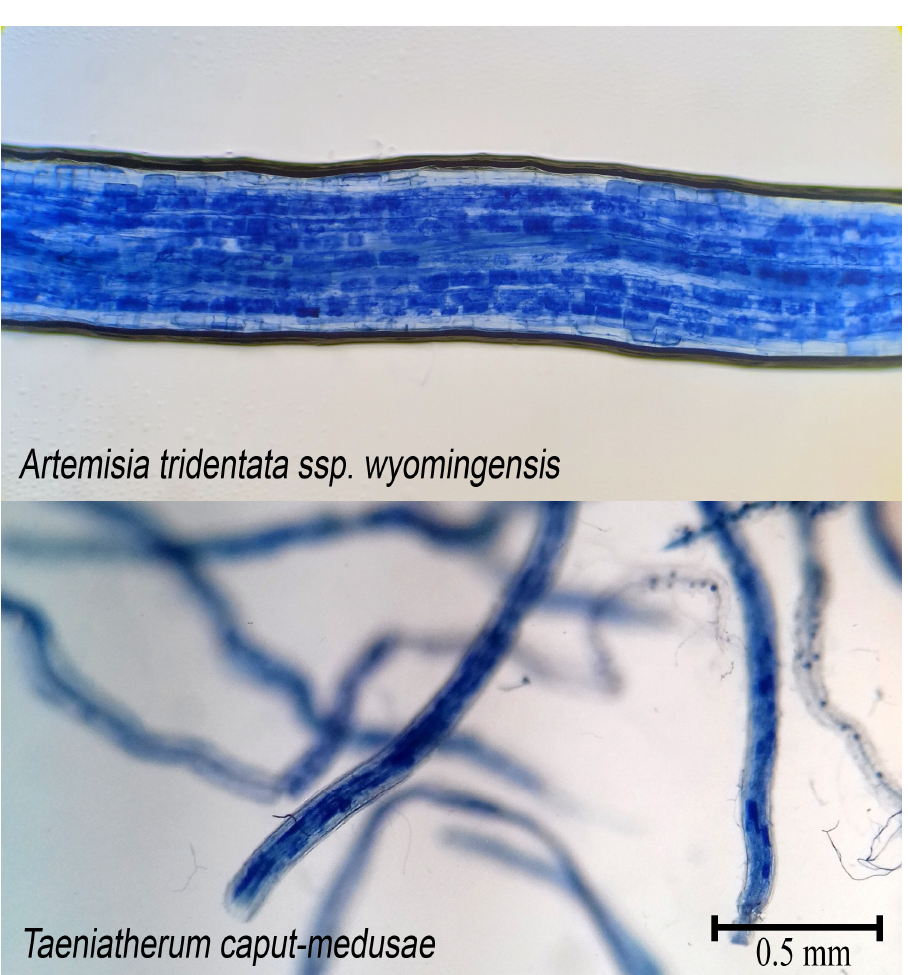
Figure 1. Cleared and stained roots of Artemisia tridentata ssp. wyomingensis and Taeniatherum caput-medusae . Arbuscules (dark blue) and hyphae from AMF can be seen colonizing cortical cells. Table 2. Mean percentages and SE of AMF colonization in roots of Artemisia tridentata ssp. wy- omingensis , A. arbuscula, and A. nova grown for 6 months in different soil, moisture, inoculum, and competition treatments.